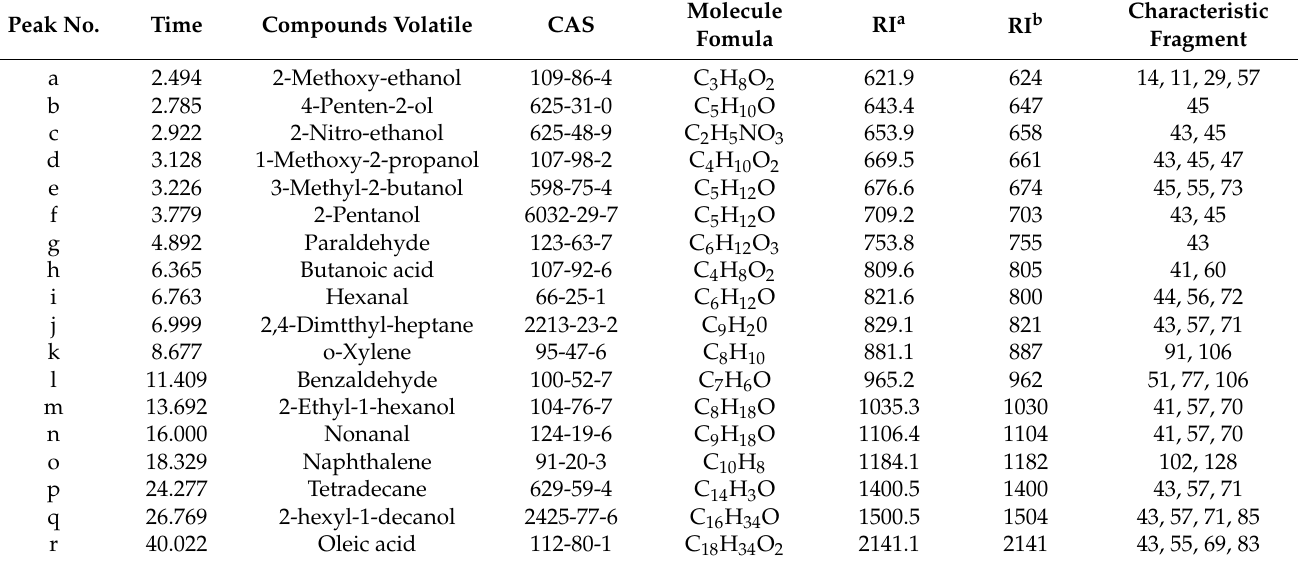
Table 1. Identification of the volatile compounds of SHS-0 h and SHS-30